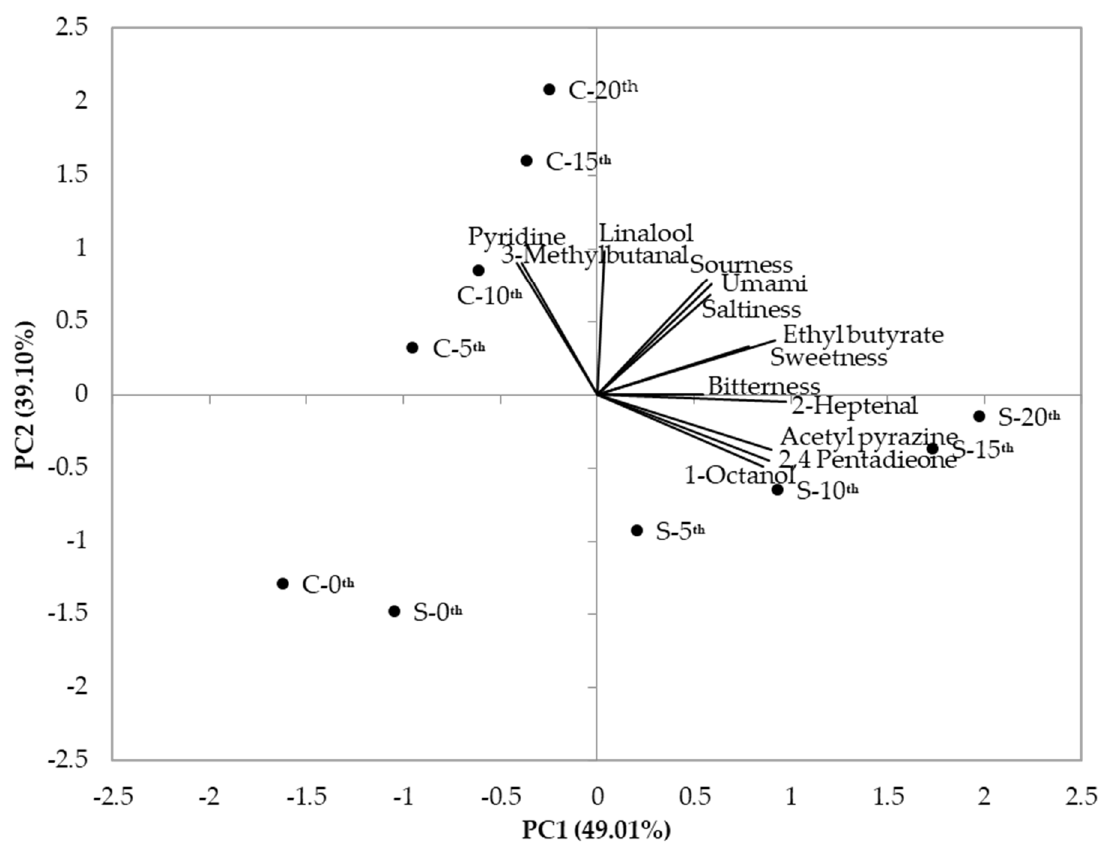
Figure 2. PCA analysis for taste and volatile patterns in repetitively fried soybean and canola oils.